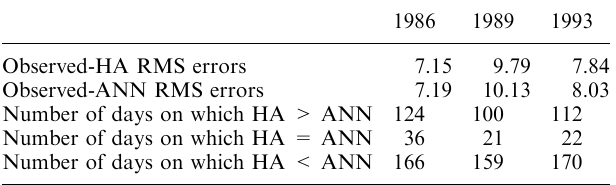
Table 3. Comparison statistics between H-component daily varia- tion curves determined by the HA and ANN methods at HER for the years 1986, 1989, and 1993